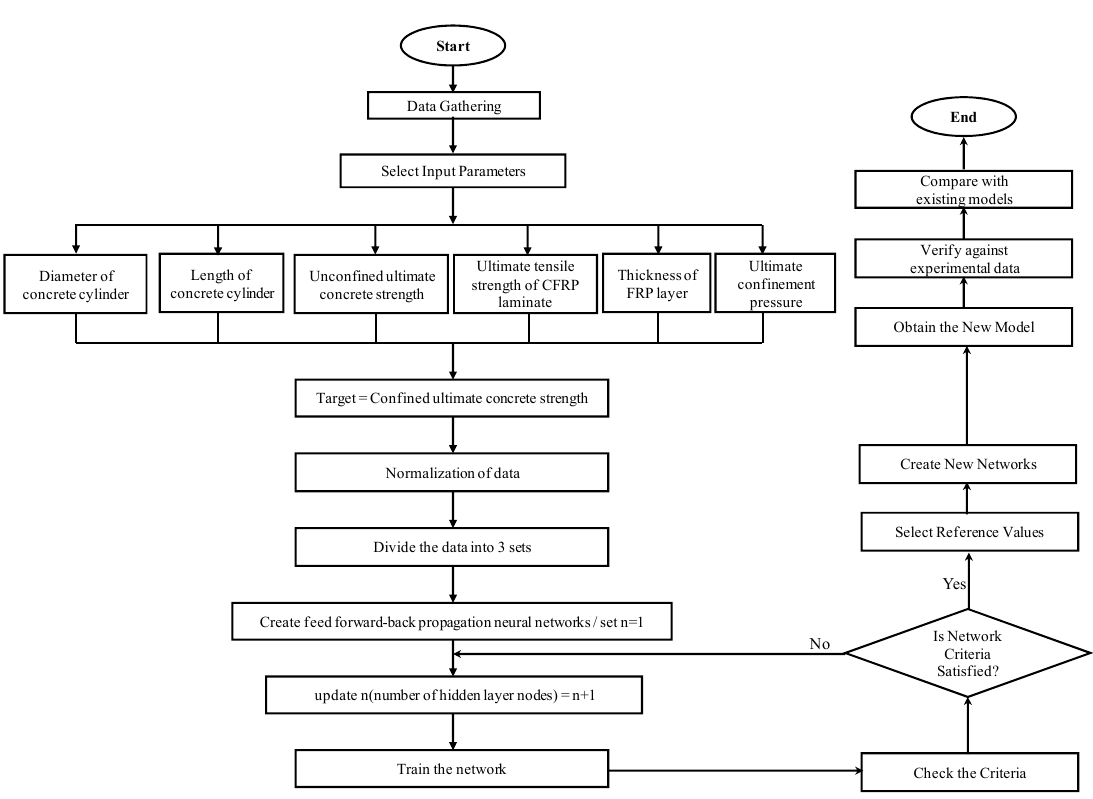
Figure 2. A three-layer artificial neural network.